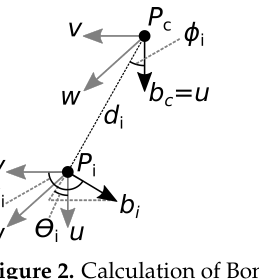
Figure 2. Calculation of Bone Pair